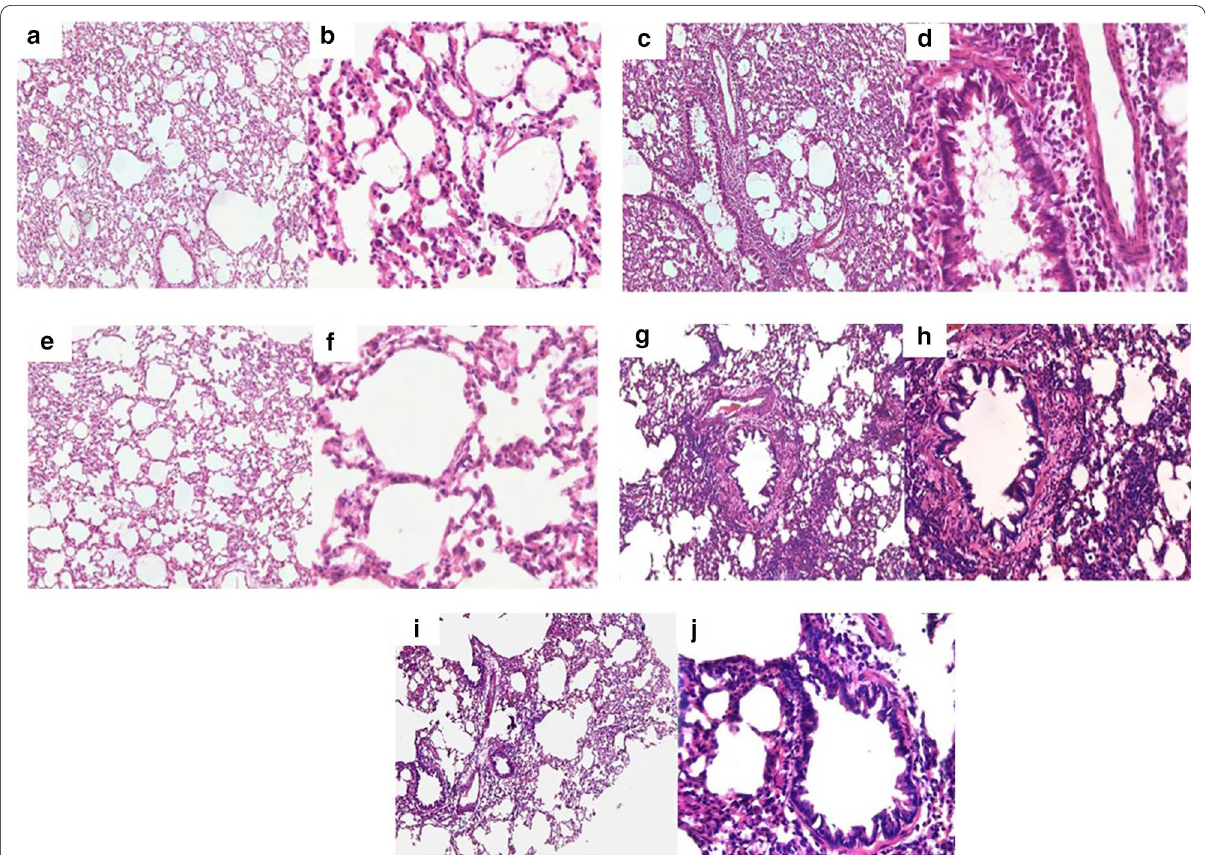
Fig. 3 Photomicrographs of lung sections from normal rats ( a , b ), OVA‑induced bronchial asthma ( c , d ), DEXA treatment group ( e , f ), NAC (300 mg/ kg) treatment group ( g , h ) and NAC (500 mg/kg) treatment group ( i , j ) (H&E